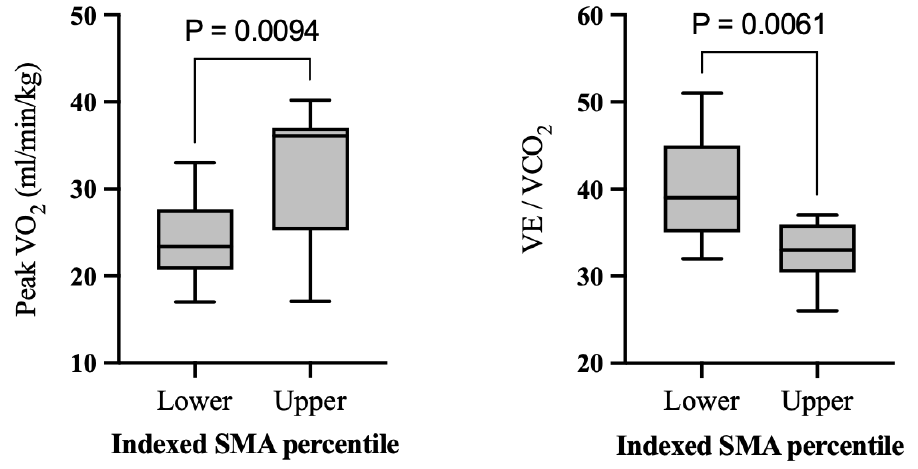
Figure 4. Significant differences in average peak VO 2 and V E /V CO2 in low- and high-muscle groups. Data presented in box and whisker plots. Bars represent upper and lower quartiles. Low-muscle peak VO 2 mean and SD is 23.8 ± 4.7 mL/kg/min (1st quartile: 20.7, median: 23.4, 3rd quartile: 27.6). High-muscle peak VO 2 mean and SD is 32.2 ± 8.5 mL/kg/min (1st quartile: 25.2, median: 36.1, 3rd quartile: 37). Low-muscle VE/VCO 2 mean and SD is 40.2 ± 6.2 (1st quartile: 35, median: 39, 3rd quartile: 45). High-muscle VE/VCO 2 mean and SD is 32.9 ± 3.6 (1st quartile: 30.5, median: 33, 3rd quartile 36). Table 5. Low and high muscle mass characteristics. Mann–Whitney U was used due to sample sizes < 30. Effect sizes were calculated by using Cohen’s d test for groups with similar sample sizes or sample sizes > 20. Hedges’ g test was used to calculate effect size for groups with largely different sample sizes or sizes < 20.